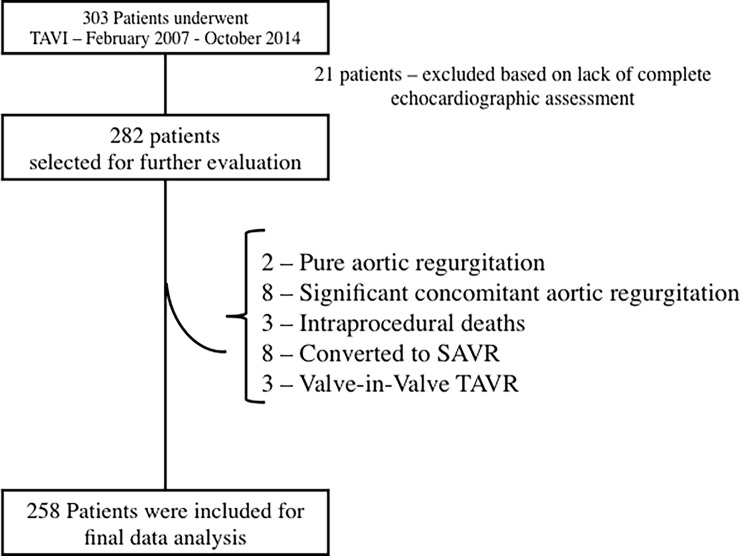
Study protocol of inclusion and exclusion criteria.SAVR = surgical aortic valve replacement, TAVR = transcatheter aortic valve replacement.